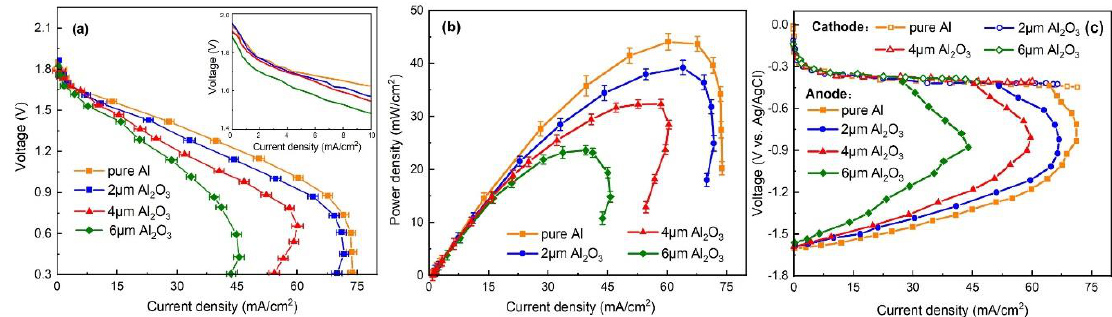
Figure 7. Polarization curves ( a ) and power density plots ( b ) of the Al–air battery modified by Al 2 O 3 interlayers of different thicknesses. ( c ) Single-cell anode and cathode polarization of the Al–air batteries modified by Al 2 O 3 interlayers with different thicknesses.